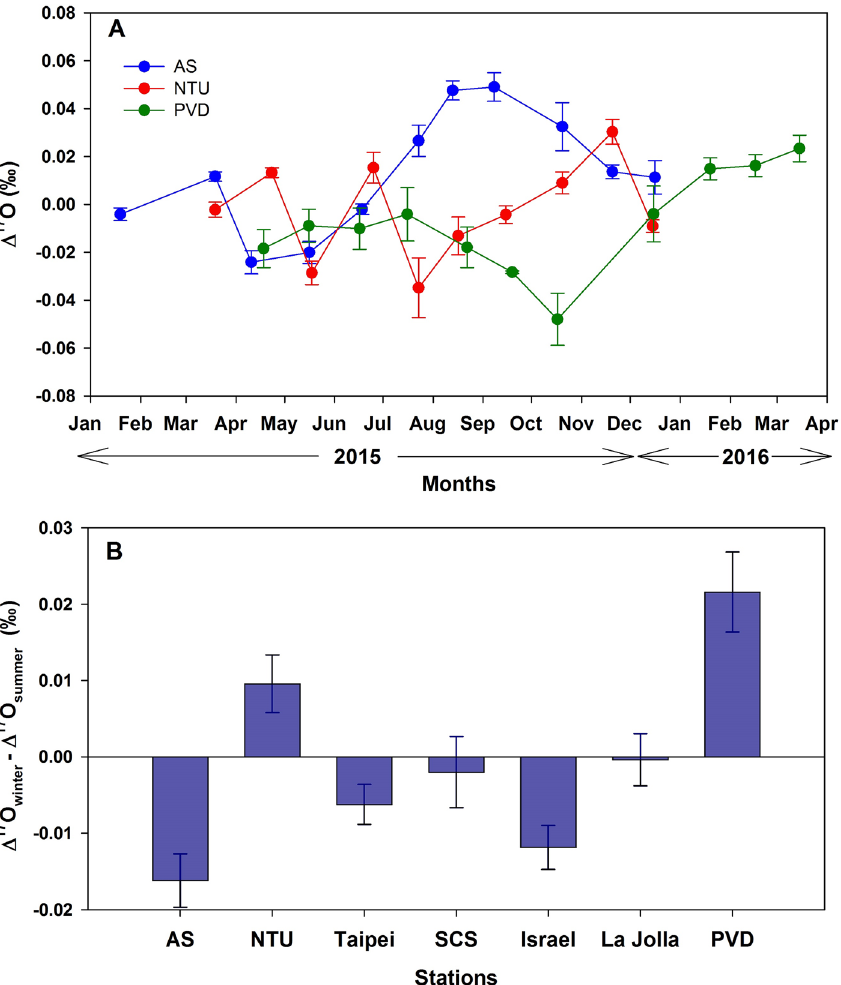
Figure 4. ( A ) Time series of the monthly averaged Δ 17 O values of CO 2 from the three selected stations, where there are regular measurements in years 2015–2016. ( B ) The difference between winter (average of January– March and October–December) and summer (April–September) averaged CO 2 Δ 17 O values. The error bars represent 1 standard error of the average.